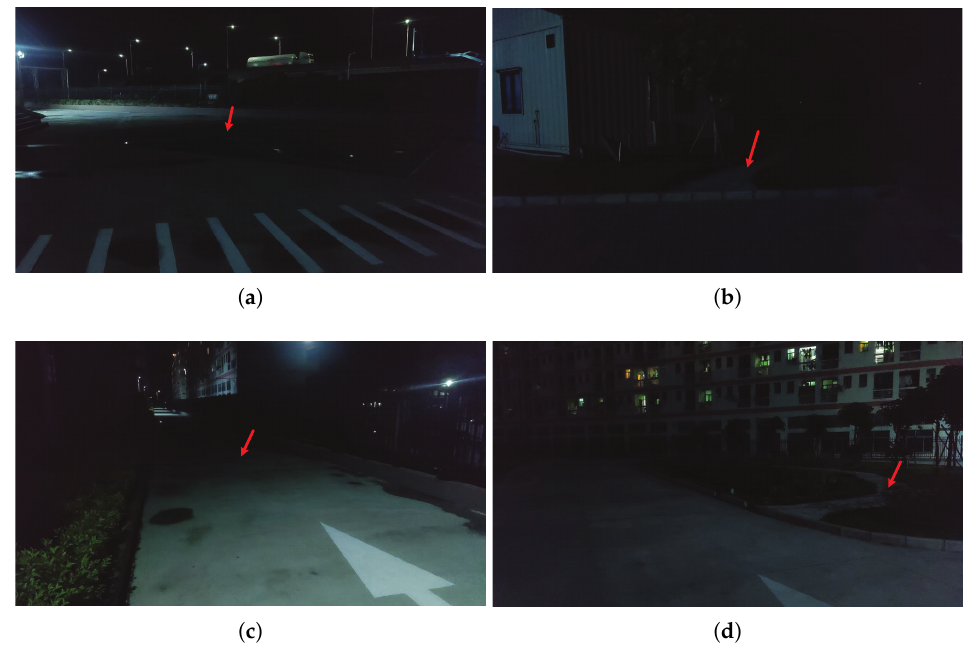
Figure 8. Selected scenes at the South China University of Technology—Zhuhai Institute of Modern Industrial Innovation campus for field experiments: ( a ) The basketball field. ( b ) The warehouse. ( c ) The fire escape. ( d ) The small garden. The red arrow in each figure indicates the landing marker’s actual position during the field tests with a measured average luminance of 5